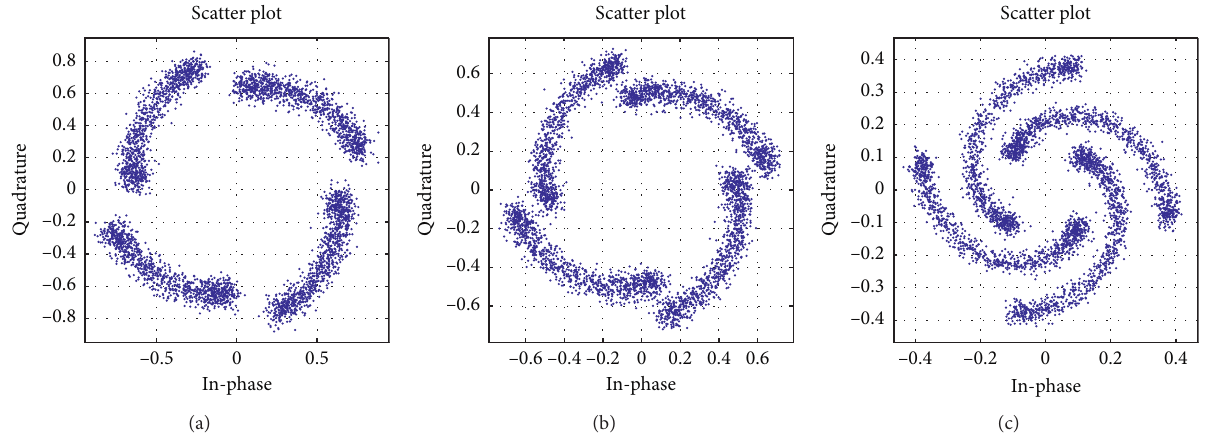
Figure 1: Constellation diagram of QPSK signal after dynamic plasma. (a) w